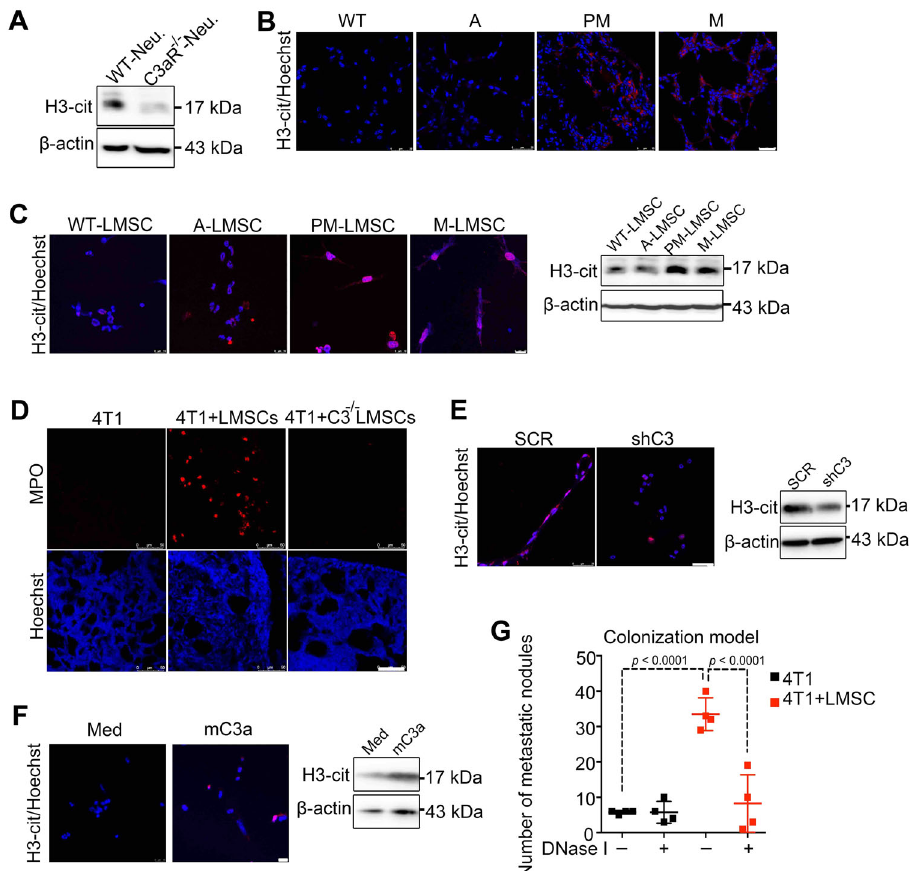
Fig. 4 C3 promotes NET-mediated metastasis. A H3-cit, a marker for NETs, was reduced in C3aR − / − neutrophils. Proteins from wild-type or C3aR − / − neutrophils were detected using western blotting analysis. The WB images were representative of three independent experiments. B Representative immuno fl uorescence images showing the H3-cit staining (red) of lung tissues from WT-lung of FVB mice or A, PM, and metastatic lung of MMTV-PyMT mice. Scale bar represents 25 μ m. The images were representative of those generated from three mice each group. C PM-LMSCs and M-LMSCs induced neutrophils to form NETs. Neutrophils (1 × 10 6 ) were co-cultured with LMSCs from MMTV-PyMT mice at different tumor stages for 24 h and were examined for H3-cit. Left, representative images of immuno fl uorescence staining. Scale bar represents 10 μ m. Right, increased H3-cit revealed by western blotting analysis. The IF images were representative of those generated from three independent experiments. WB was done twice. D NET formation in the lungs of tumor-bearing mice required C3. 4T1 cells were co-injected with WT or C3 − / − LMSCs into BALB/c mice. Lung tissue sections were stained anti- MPO. Scale bar represents 50 μ m. The images were representative of those generated from three mice each group. E Knockdown of C3 in LMSCs reduced NETs in co-cultured neutrophils. Neutrophils (1 × 10 6 ) were co-cultured with SCR or shC3 PM-LMSCs for 24 h and were examined for H3-cit. Scale bar represents 25 μ m. Right, decreased H3-cit expression revealed by western blotting analysis. The images were representative of three independent experiments. WB was repeated once. F mC3a induced NET formation. Neutrophils (1 × 10 6 ) were treated with recombinant mC3a (1 μ g/ml) for 24 h and examined for H3-cit. Scale bar represents 10 μ m. Med was the cultured medium. The images were representative of three independent experiments. WB